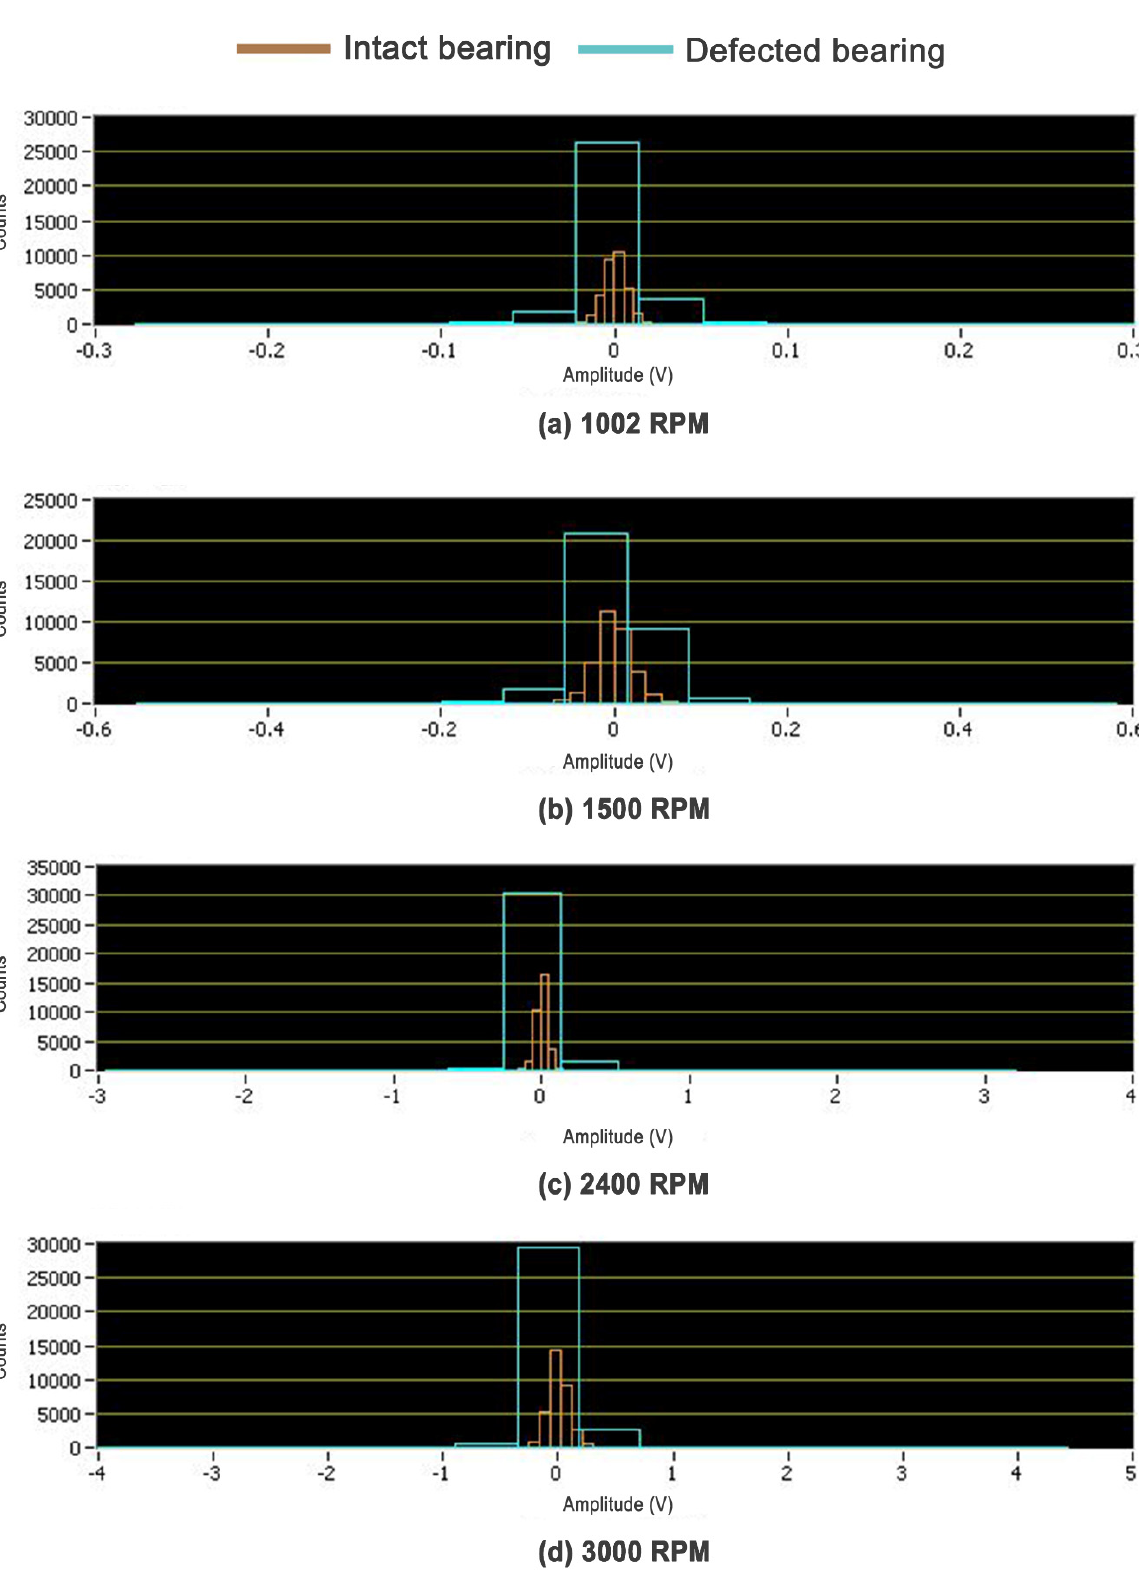
Figure 6. Histograms for ball damage without installing a bearing loader.